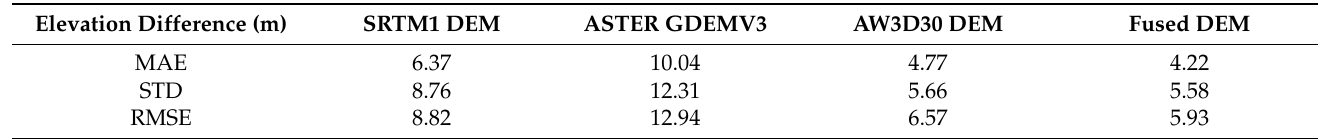
Table 3. Result of elevation difference between SRTM1 DEM, ASTER GDEM V3, AW3D30 DEM, Fused DEM, and reference